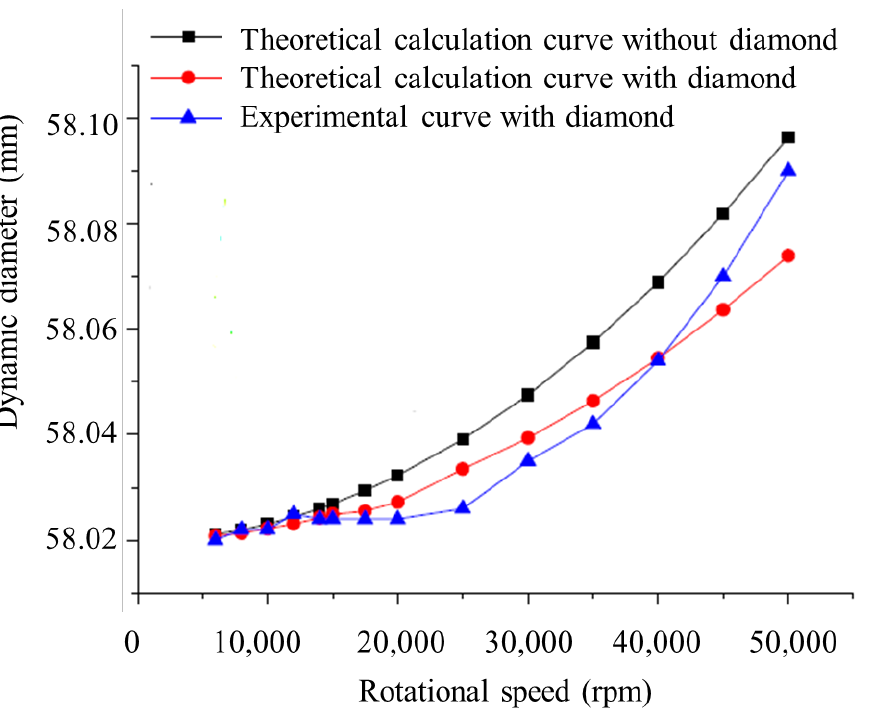
Figure 16. Dynamic diameter variations at different rotational speeds. Adapted with permission from Ref. [70]. 2018, Elsevier.